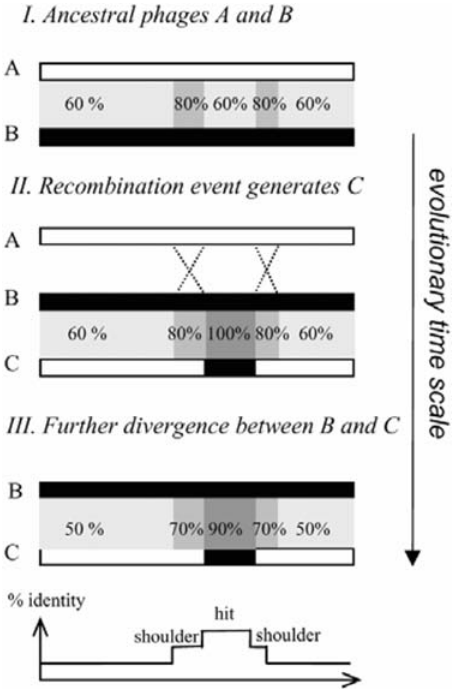
Figure 5. Evolutionary history of event between diverged viruses A and B, produces virus C which is similar to A but for a patch of DNA (hit) coming from B. Alignment of phage B to C reveals at the border of the patch two regions of intermediate similarity (shoulders, here drawn in grey). Below is shown the % identity profile of the B to C virus alignment.